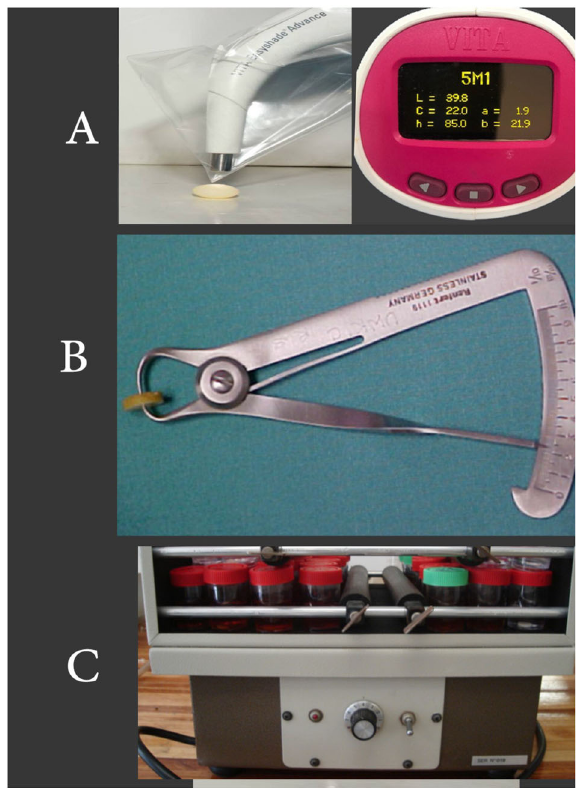
Fig. 1 The shade. A Recording with spectrophotometer display against white background and L * a * b * readings. B Iwanson spring. C Orbital shaker.